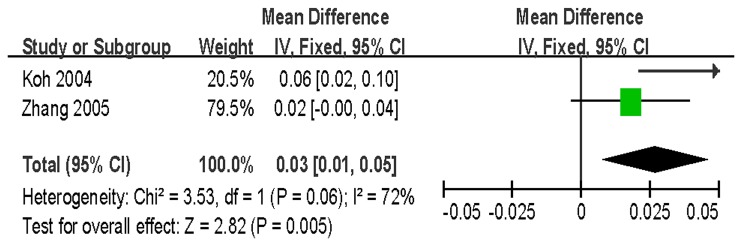
WMD and 95% CI in FN BMD between Q89R QQ and QR/RR genotypes.